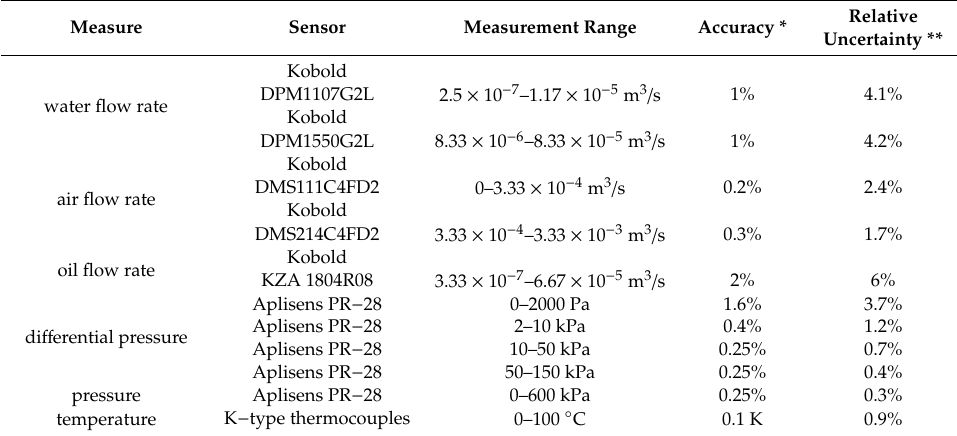
Table 2. Specification of measuring